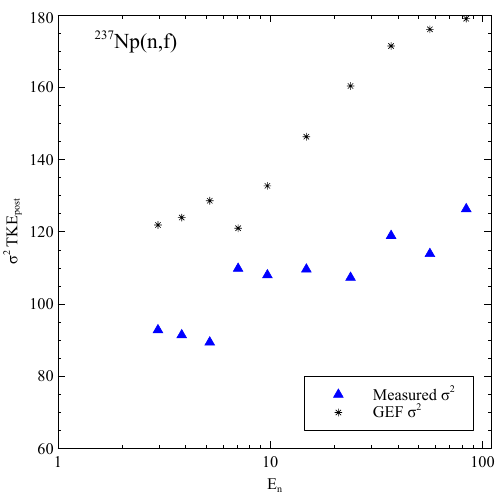
Figure 4. Measured and GEF calculated variances of the TKE distributions for the fast neutron induced fission of 232 Th.